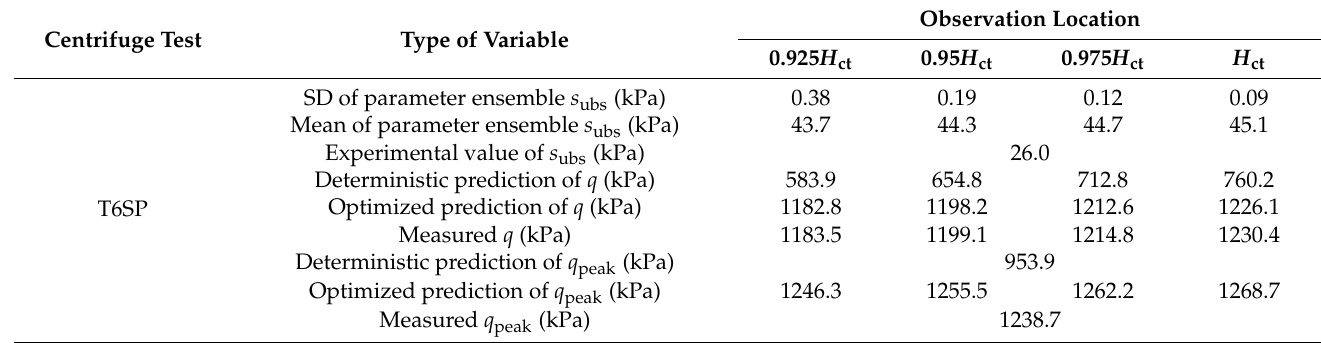
Table 6. Variations of data during the process of parameter optimization for Test T6SP.